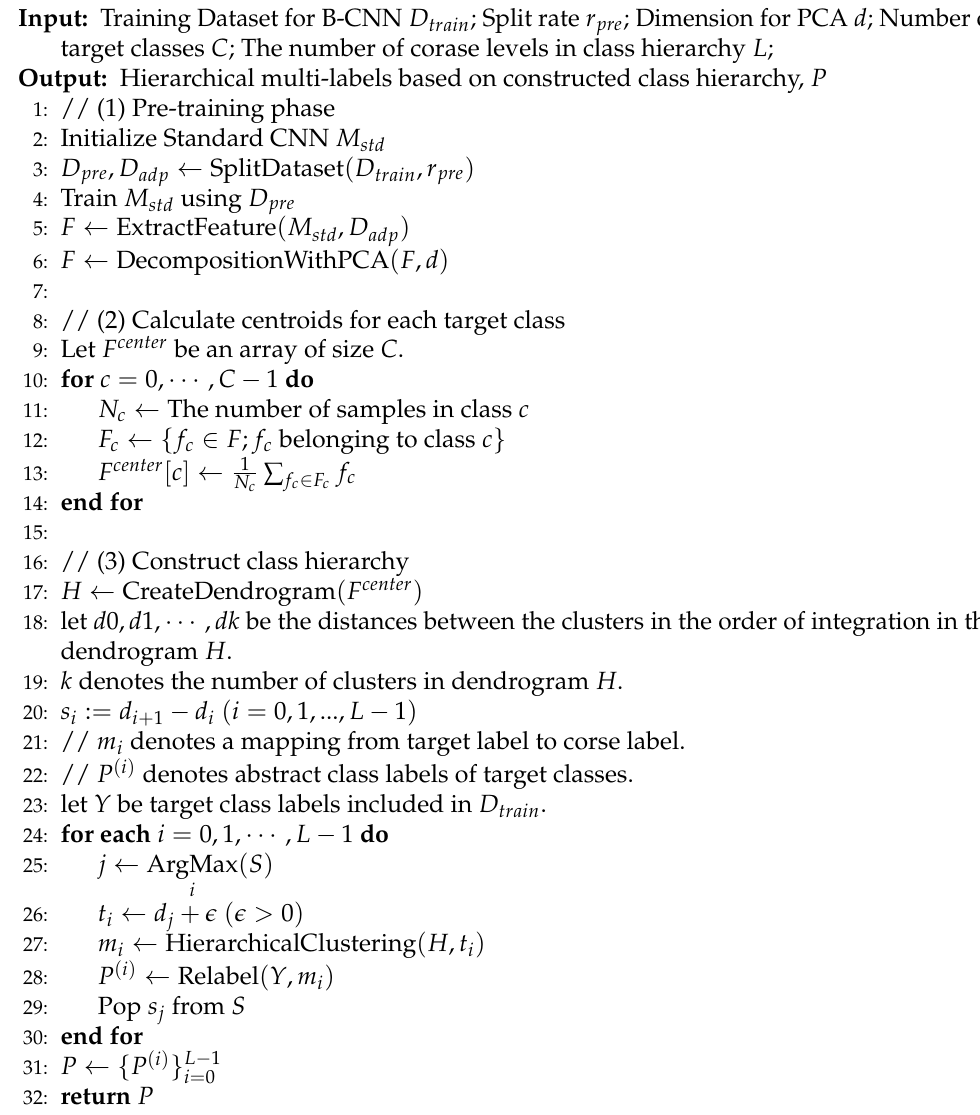
Algorithm 2 Constructing a class